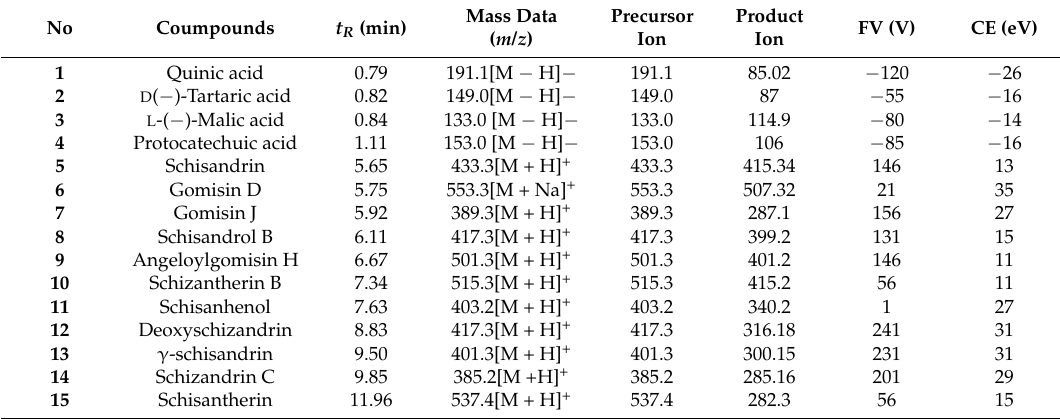
Table 1. Precursor/product ion pairs and parameters for MRM of the target